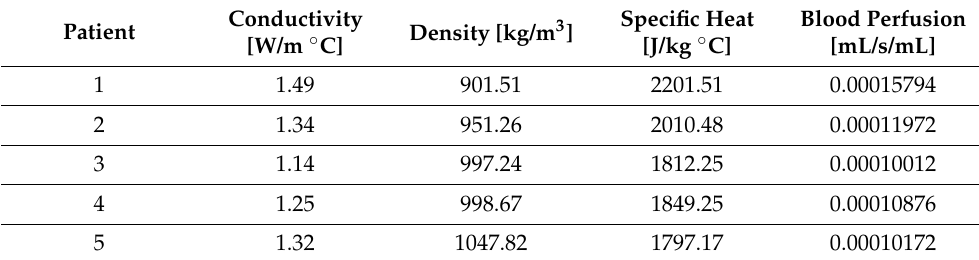
Table 6. Estimated parameters of the homogeneous model.